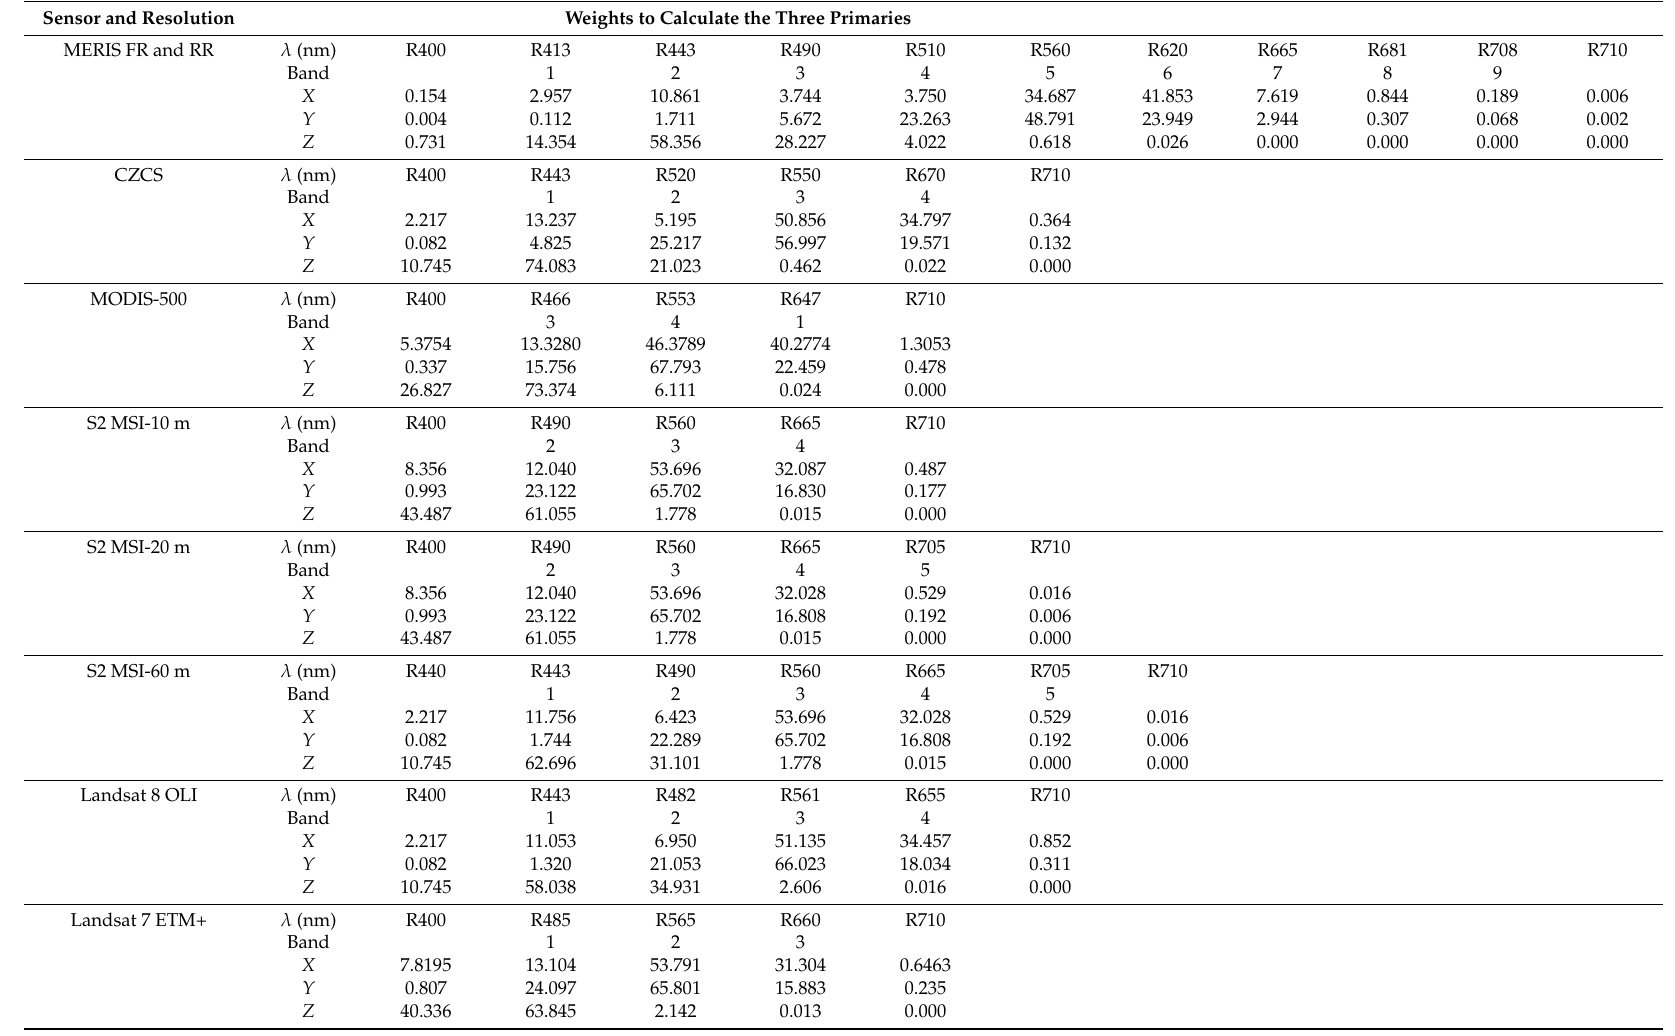
Table 1. Linear coefficients to calculate the chromaticity values ( X , Y , Z ) for eight sensor configurations. Sensor and